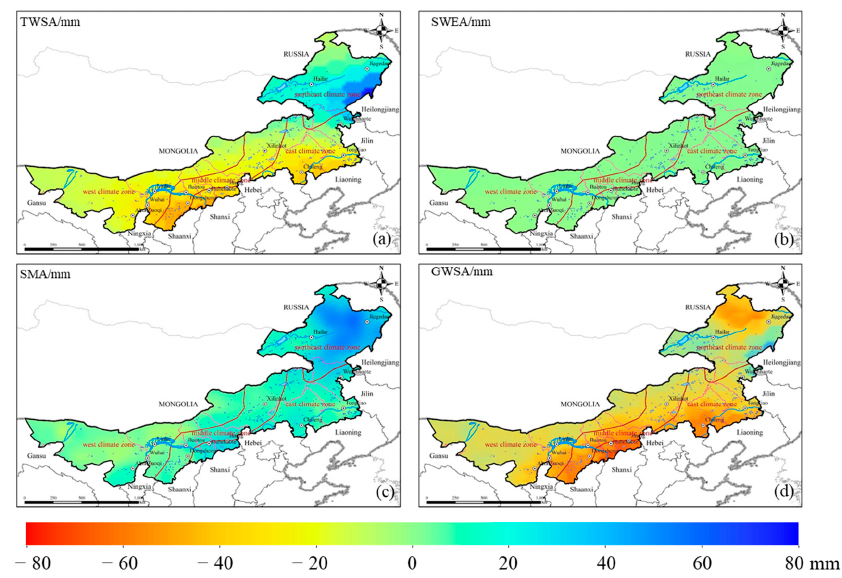
Figure 4. Spatial distribution of mean annual TWSA and its components (SMA, SWEA, GWSA) in 2003–2021.